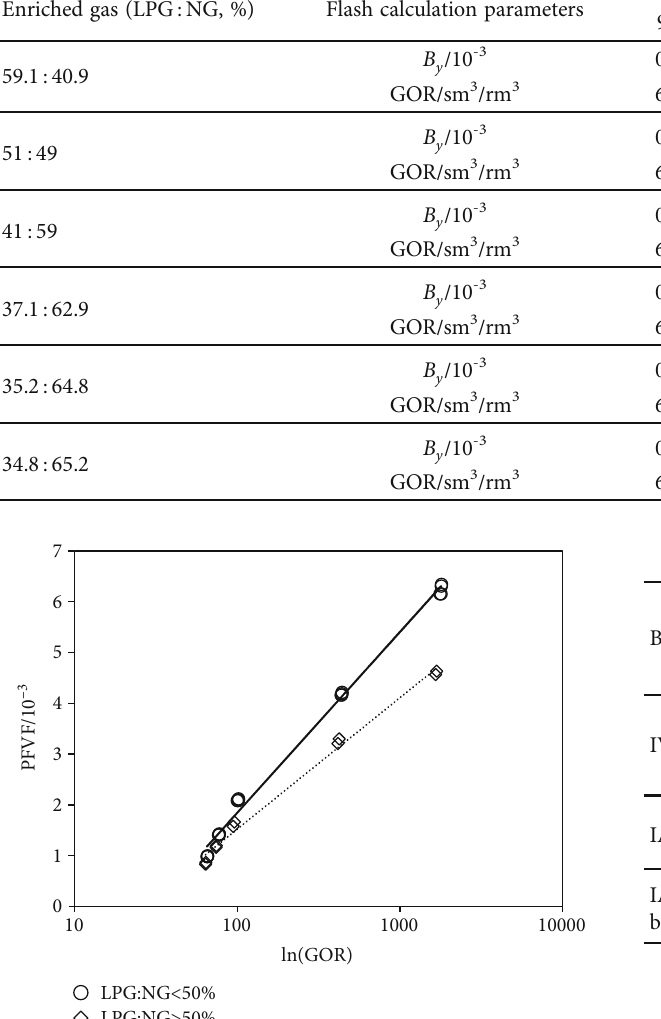
Table 1: Flash calculation results of PFVF and GOR of di ff erent composition of enriched gas mixed with crude oil in di ff erent proportions. Enriched gas (LPG :NG, %)